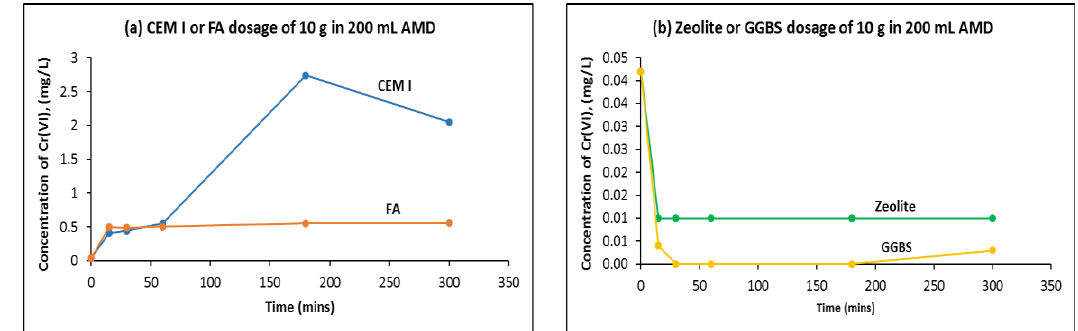
Figure 2. E ff ects of contact time on adsorption of Cr(VI) by the various adsorbents: ( a ) CEM I and FA Figure 2. Effects of contact time on adsorption of Cr(VI) by the various adsorbents : ( a ) CEM I and FA adsorbents; ( b ) Zeolite and GGBS adsorbents; ( b ) Zeolite and GGBS adsorbents.